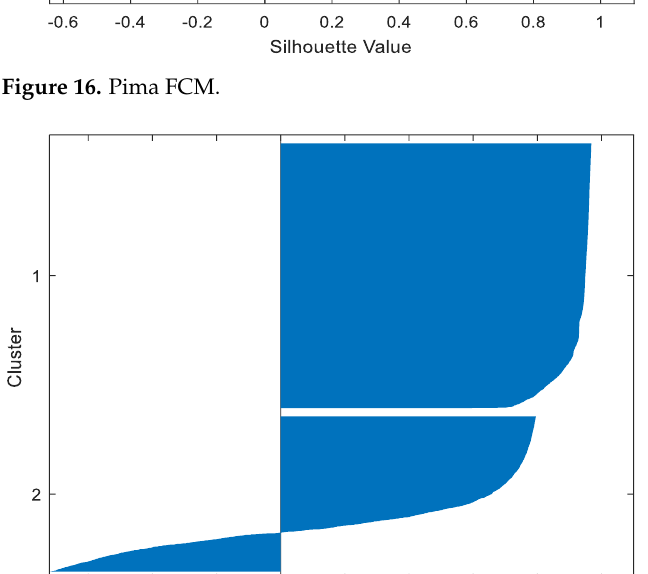
Figure 16. Pima FCM.